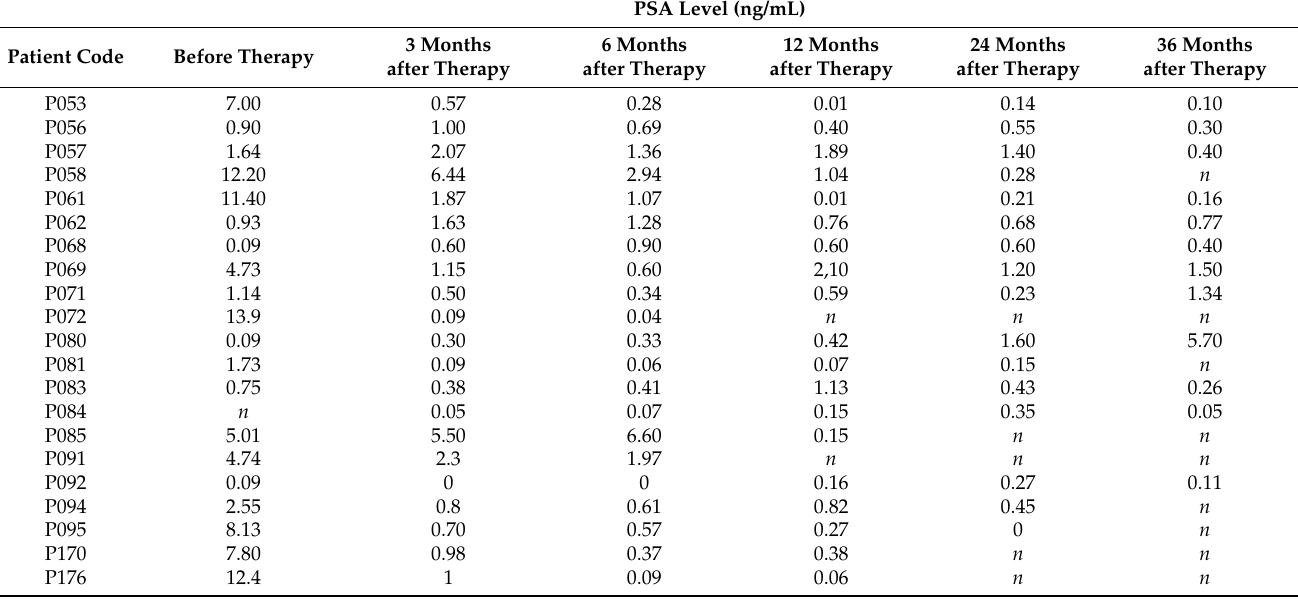
Table 2. PSA values (ng/mL) of prostate cancer patients before and at multiple time points after brachytherapy. ‘ n ’: not